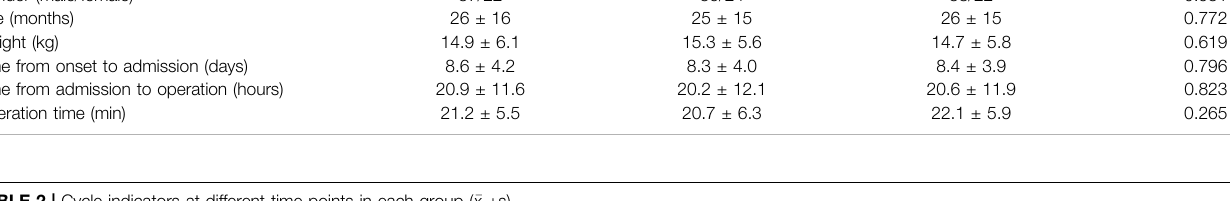
TABLE 2 | Cycle indicators at different time points in each group ( (cid:1) x ±s ). Group